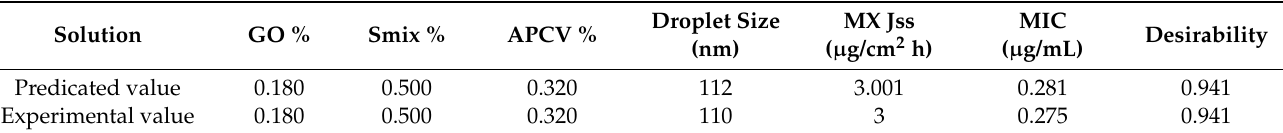
Table 4. Actual and experimental values of the optimized nanoemulsion